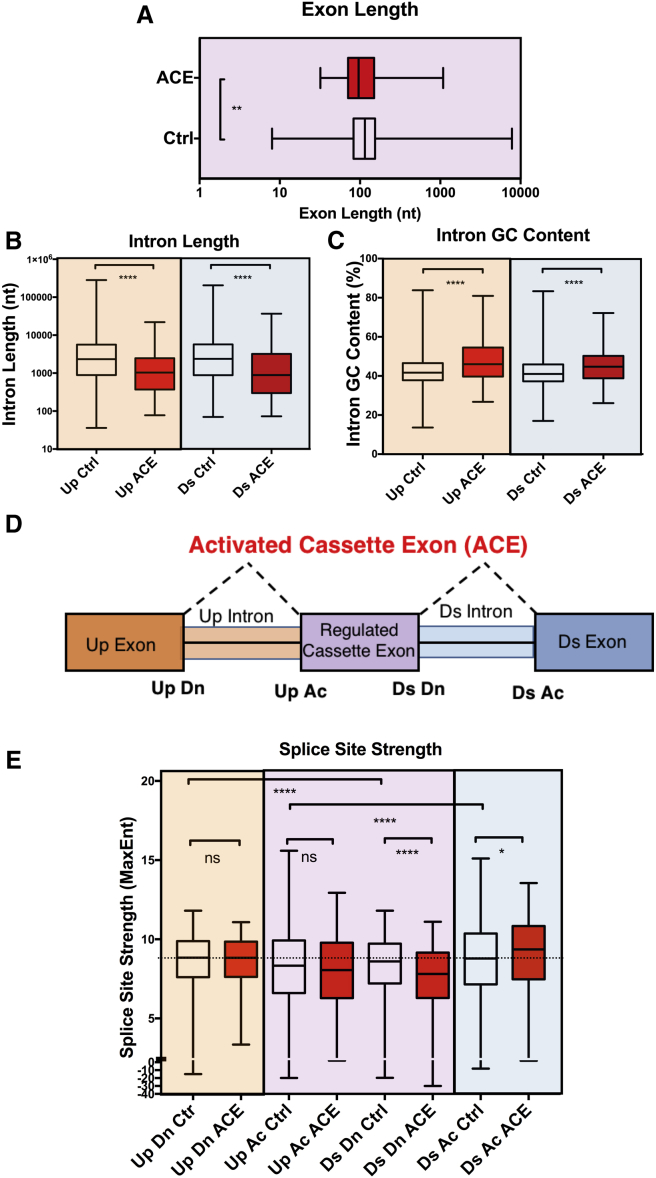
Properties of Pat1b-Regulated Cassette Exons(A) Length distribution of Pat1b-regulated exons.(B) Length distribution of introns (upstream and downstream).(C) Intron GC content (percentage).(D) Schematic cartoon of features of activated cassette exons regulated by Pat1b. Up, upstream; Ds, downstream; Dn, donor; Ac, acceptor.(E) Splice site strength (maximum entropy). A two-sided Mann-Whitney test was used to compare properties between datasets (ns, p > 0.05; ∗p < 0.05; ∗∗p < 0.01; ∗∗∗p < 0.001; ∗∗∗∗p < 0.0001).